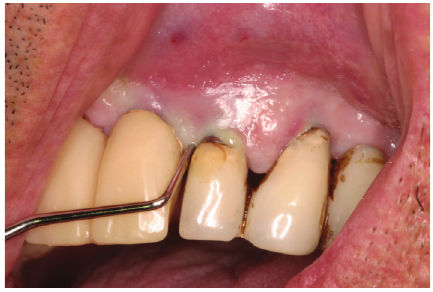
Figure 1: Peri-implantitis with